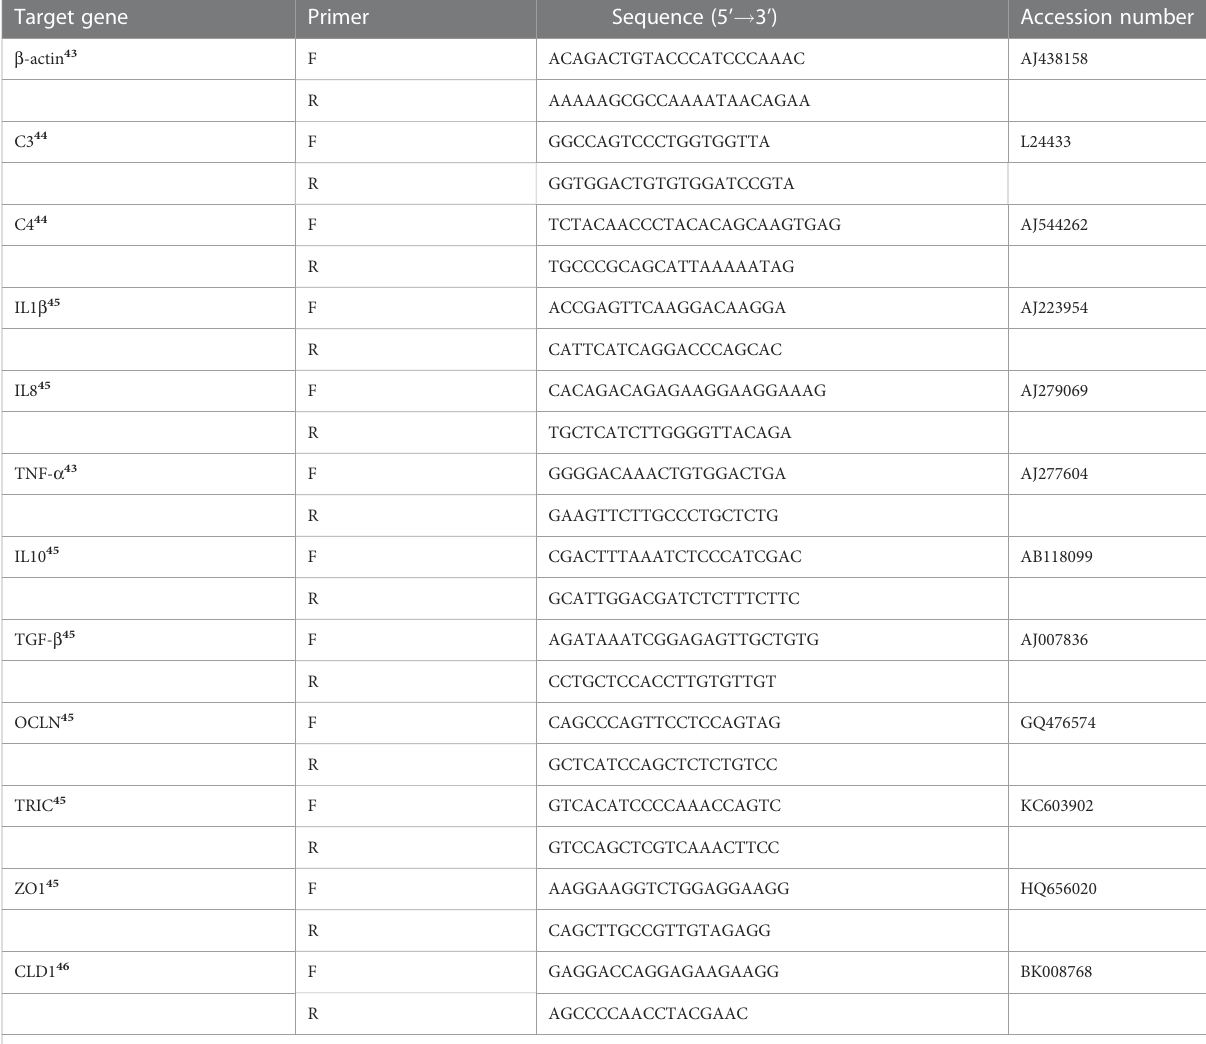
TABLE 3 Speci fi c primers for Real-time